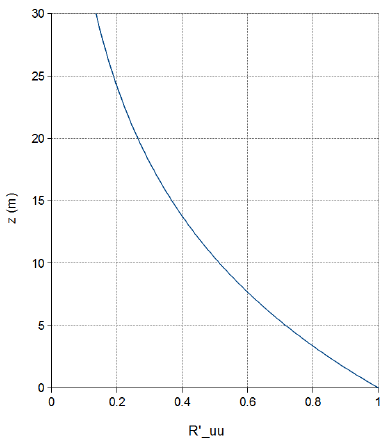
Figure 2. Vertical profile of normalised streamwise Reynolds stress at the inlet, as a function of